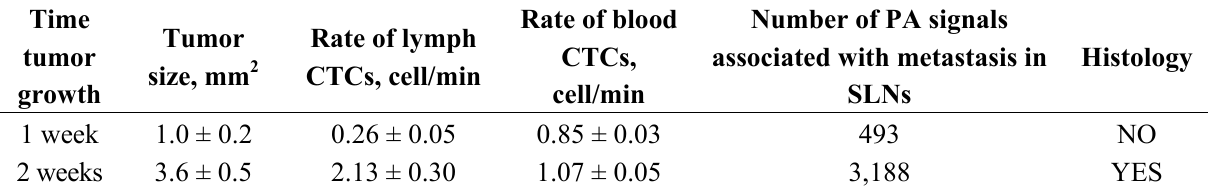
Table 1. Correlation between primary tumor size, metastasis in SLN and number of tumor cells in lymph and blood flow